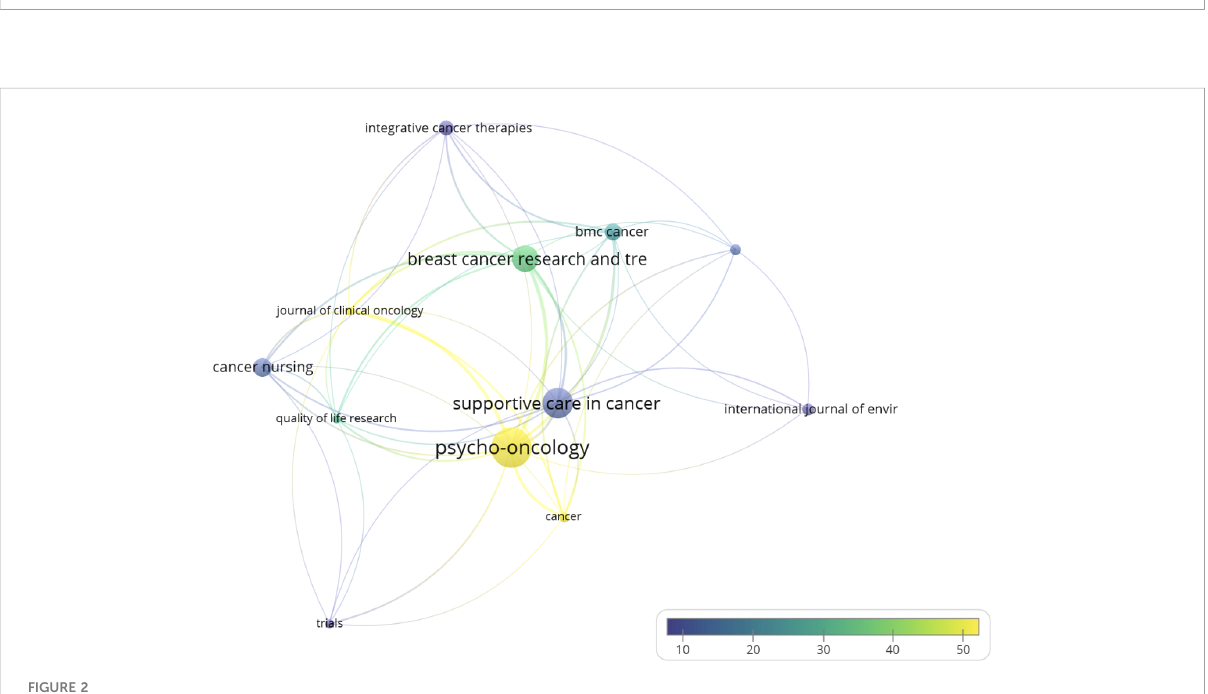
FIGURE 2 Core of journals.